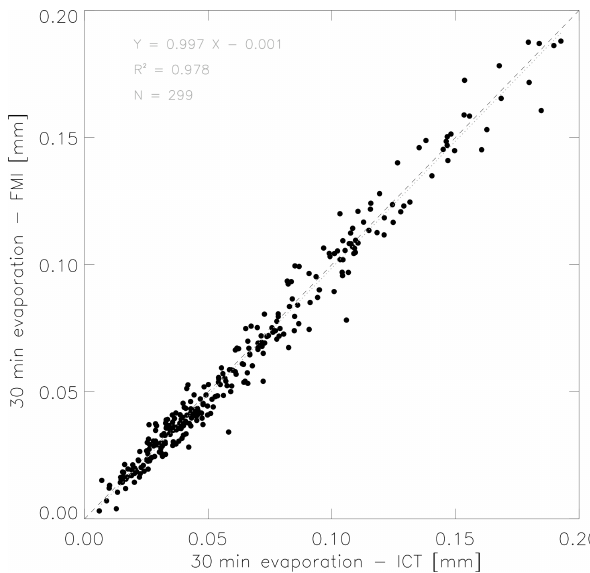
Figure A2. Scatter plot between 30min evaporation from both in- struments: the y axis shows the values estimated after the measure- ments by the IRGASON of the FMI, and the x axis shows the values after the measurements of the IRGASON of the